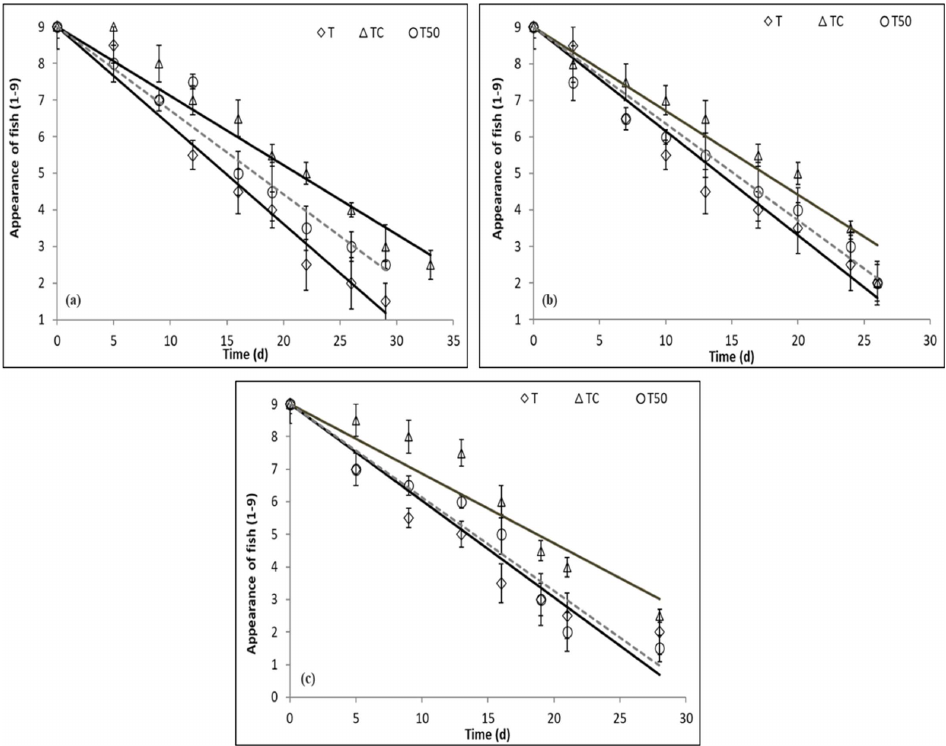
Figure 10. Scores of appearance of sea bream samples slaughtered in ( a ) September 2020, ( b ) January 2021, and ( c ) April 2021 during storage at 0 °C ( ◇ T, △ TC, ○ T50).